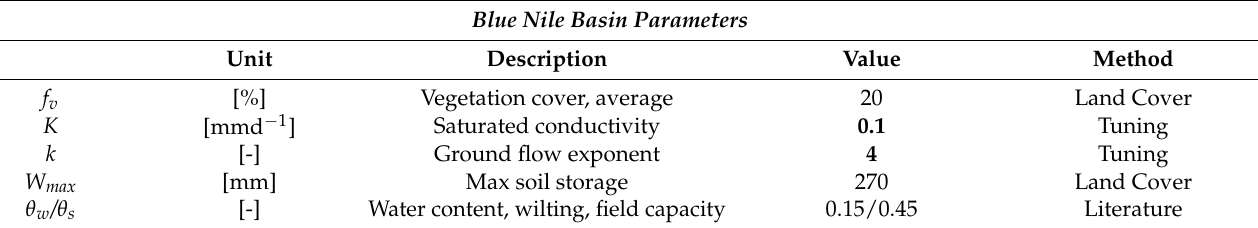
Table 4. Calibration of Poli-Hydro model. Blue Nile. In bold, values of the calibration parameters. Blue Nile Basin